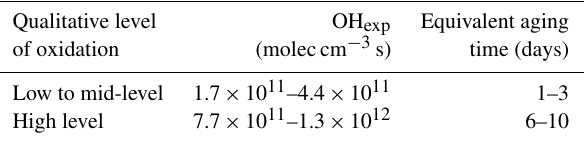
Table 1. Qualitative levels of PAM-reactor oxidation with corre- sponding OH exposure (OH exp ) estimations and equivalent aging times. The OH exp estimations were made using methods described in the Supplement (Methods: PAM Calibrations and Equivalent Ag- ing